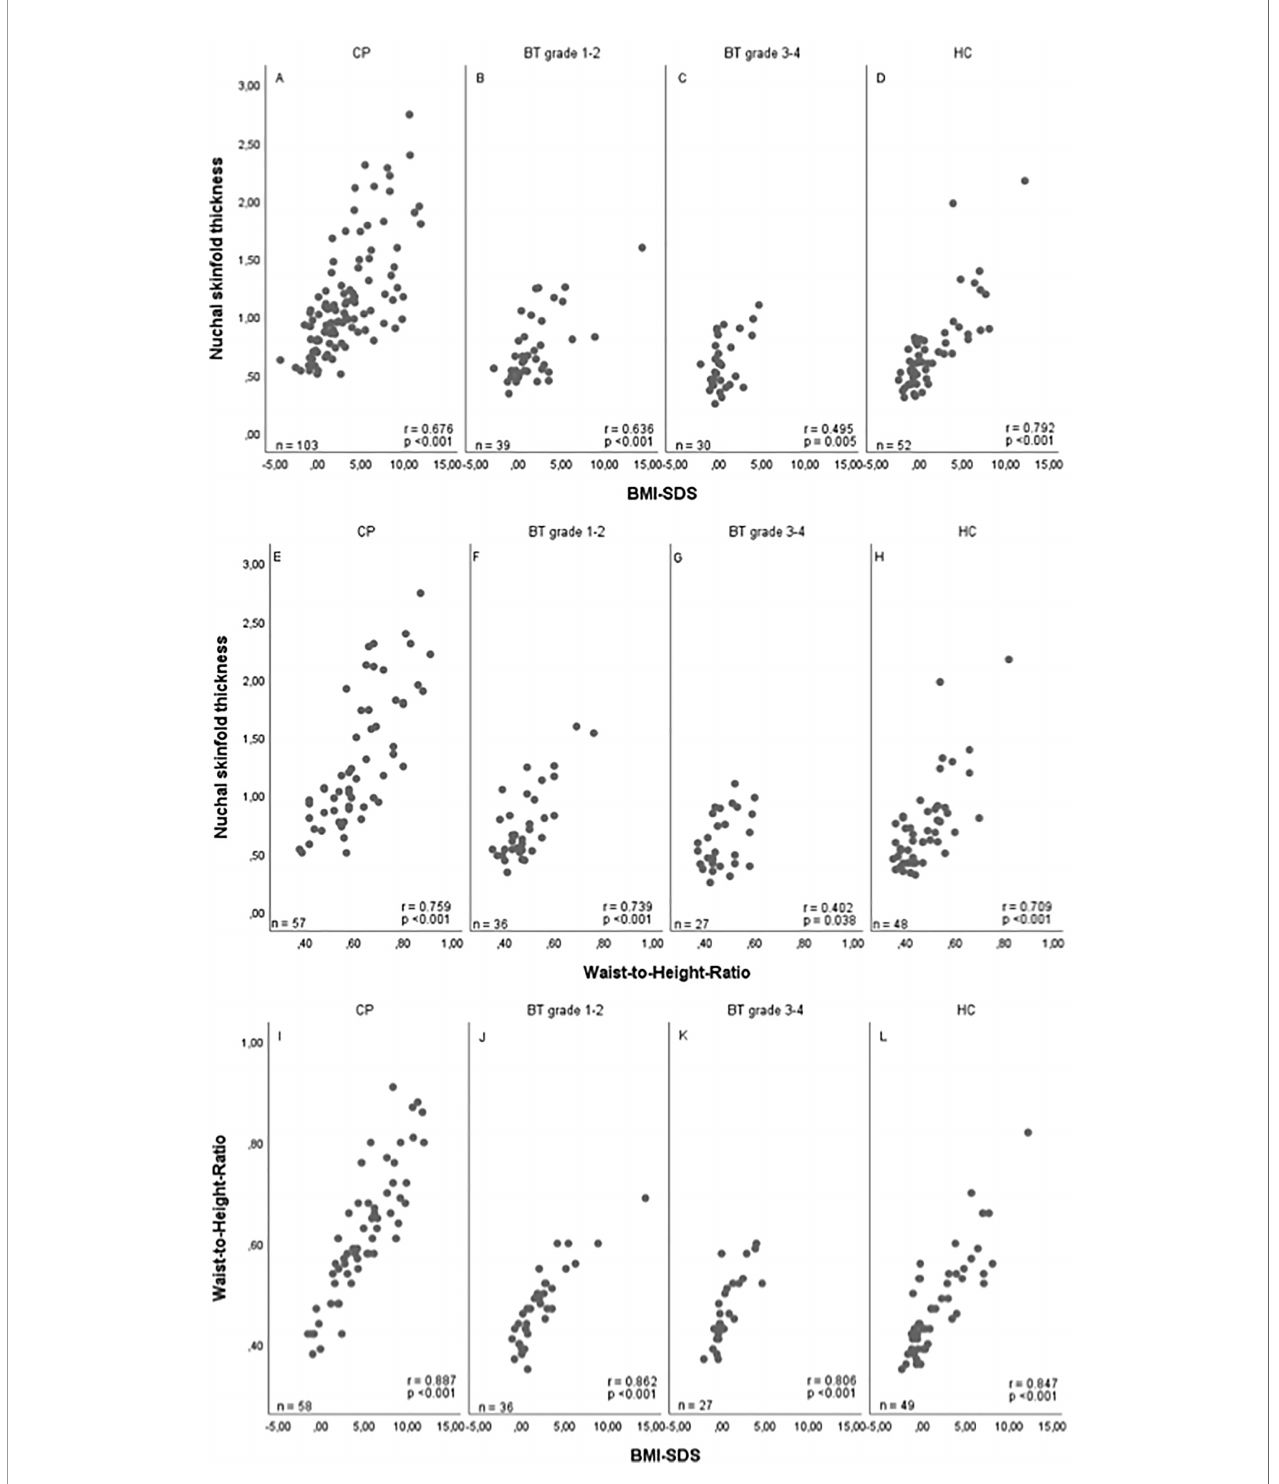
FIGURE 2 | Correlations between nuchal skinfold thickness (NST) as measured (cm) on cranial magnetic resonance (MRI) imaging and body mass index (BMI) SDS (32) (A – D) , between NST and waist-to-height ratio (E – H) , and between BMI SDS and waist-to-height ratio (I – L) in patients with childhood-onset craniopharyngioma (CP) recruited in HIT Endo and KRANIOPHARYNGEOM 2000/2007 (A, E, I) , WHO grade 1 or 2 brain tumor (BT) patients (B, F, J) , WHO grade 3 or 4 BT patients (C, G, K) , and healthy controls (HC) (D, H, L) . r = Pearson correlation coef fi cient; SDS, standard deviation